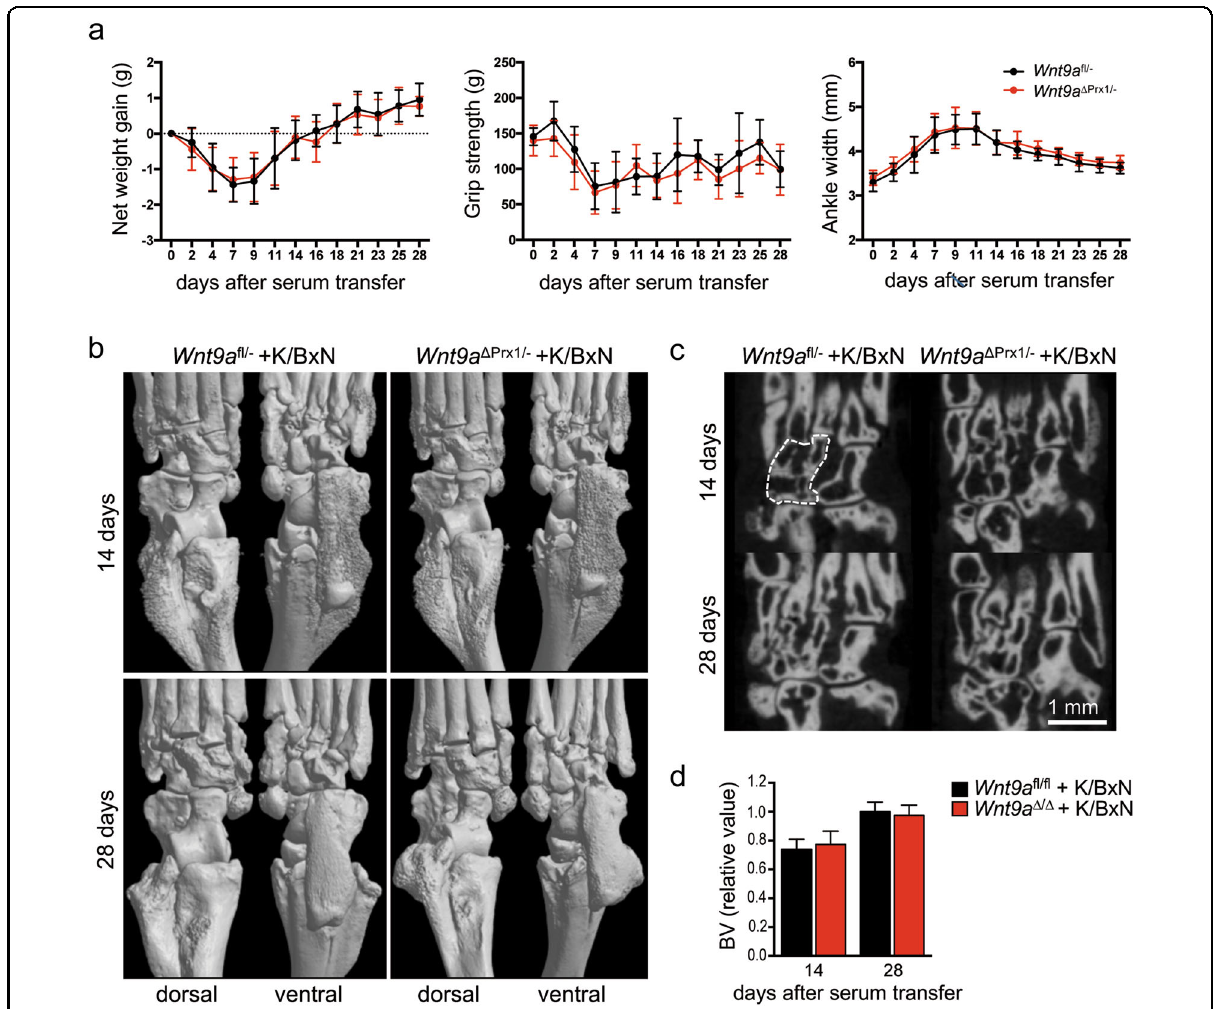
net weight gain, grip strength, and ankle width in K/BxN-treated control ( Wnt9a fl / − ) and Wnt9a -de fi cient mice over 28 days. b Three- and c two- dimensional microCT images of Wnt9a fl / − (control) and Wnt9a -de fi cient hind paws, 14 ( n = 19) and 28 days ( n = 9) after K/BxN serum transfer. d Quanti fi cation of the bone volume in the area outlined by the white dashed line in c , encompassing the navicular, intermediate, and lateral cuneiform bones, at the 14- ( n = 10) and 28-day ( n = 9)